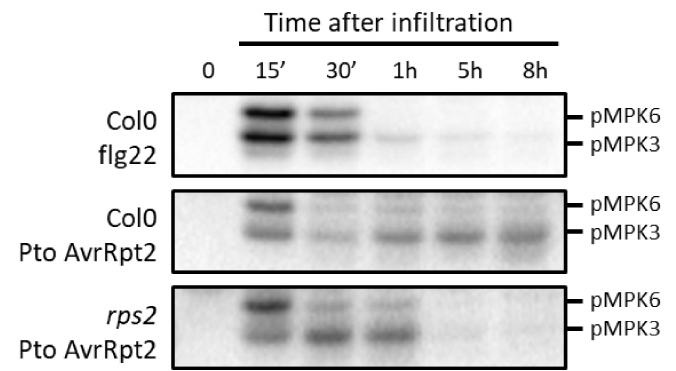
Figure 2. Transient versus sustained activations of MPK3 / 6 in response to PAMPs and e ff ectors, respectively. Inspired by Tsuda et al. [49]. The leaves of six-week-old Arabidopsis Col0 and rps2 plants (grown in short day conditions in soil) were infiltrated with 1mM of the PAMP flg22 or with Pto expressing AvrRpt2 (OD600 nm = 0.015) for di ff erent periods of time, and MPK3 / 6 activities were measured by immunobloting using an anti-pTpY antibody recognizing the dual phosphorylation of the TXY motif.